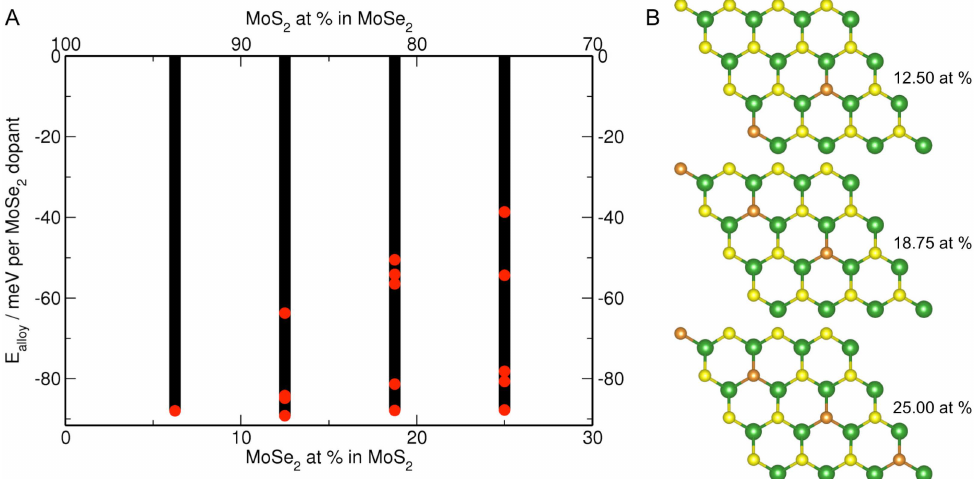
Figure 9. ( A ) The alloying energies (E alloy , in meV per MoSe 2 unit) of the MoSe 1 ´ x S x systems with Se atoms included in both chalcogen layers and ( B ) selected alloys with the most stable symmetric Se arrangement for a given concentration. Green, Mo; orange, Se; yellow,